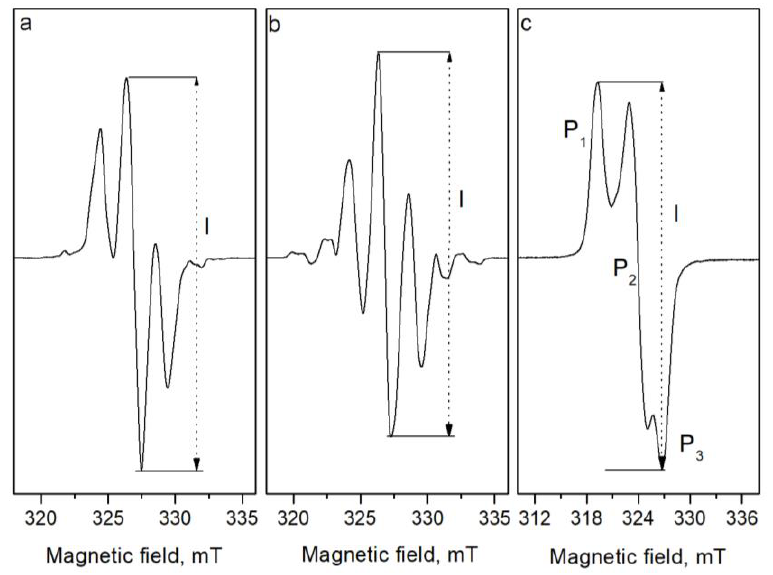
Figure 1. EPR spectra of ( a ) L-proline, ( b ) DL-proline, and ( c ) cysteine after γ -irradiation with 10 kGy.